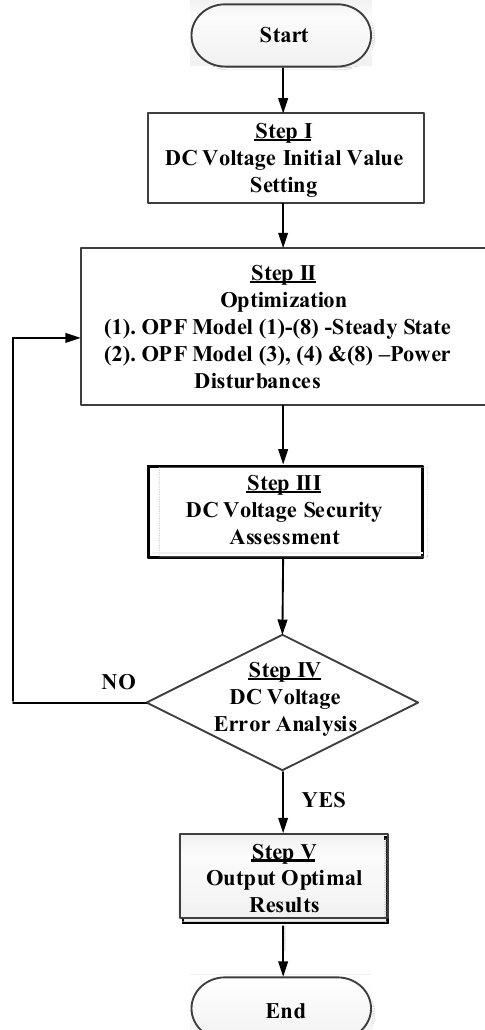
Figure 1. DC optimal power flow (OPF) algorithm in the secondary controller.